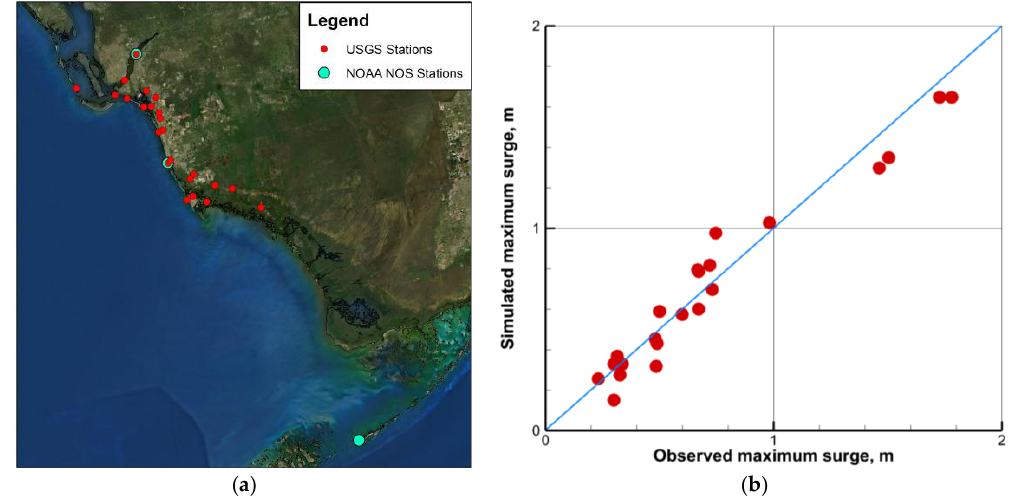
Figure 16. Map of data stations with observed data ( a ) and comparison between observed and simulated (hindcast) and peak surges during Hurricane Wilma ( b ).